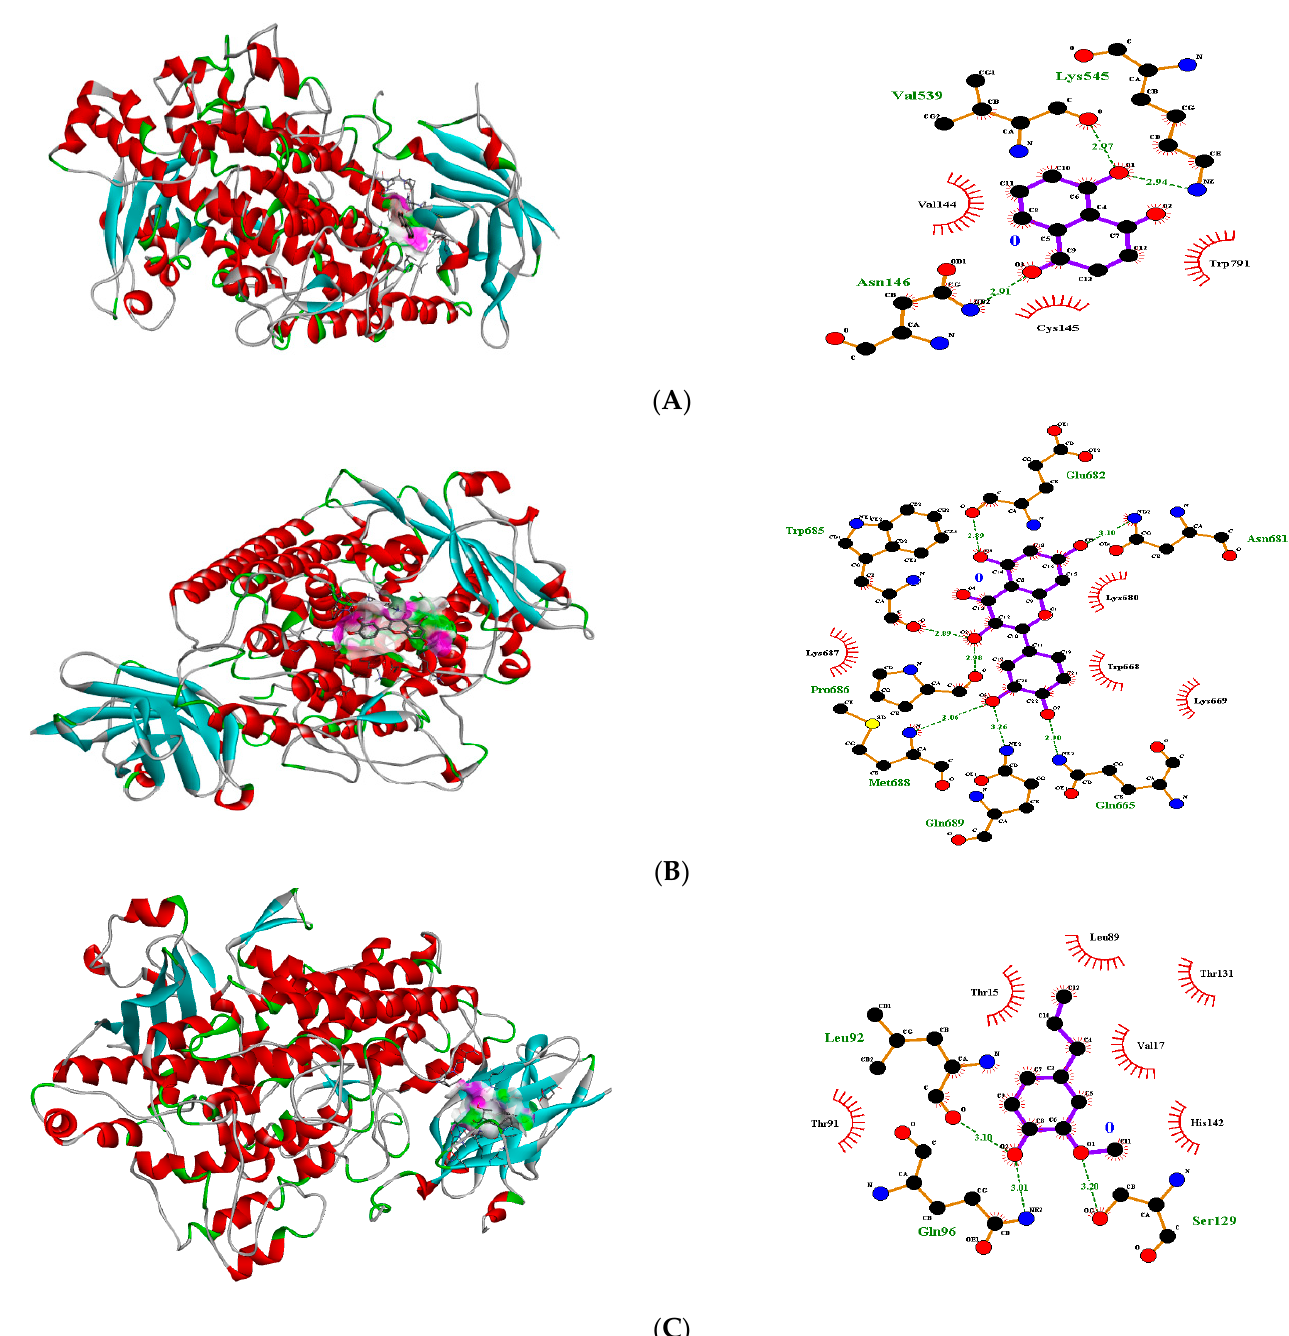
Figure 1. 3D H-bonding interactions of juglone pose no. 3 ( A ), quercetin pose no, 4 ( B ); gallic acid pose no. 2 ( C ) with binding sites of transcriptional regulator 3TOP.